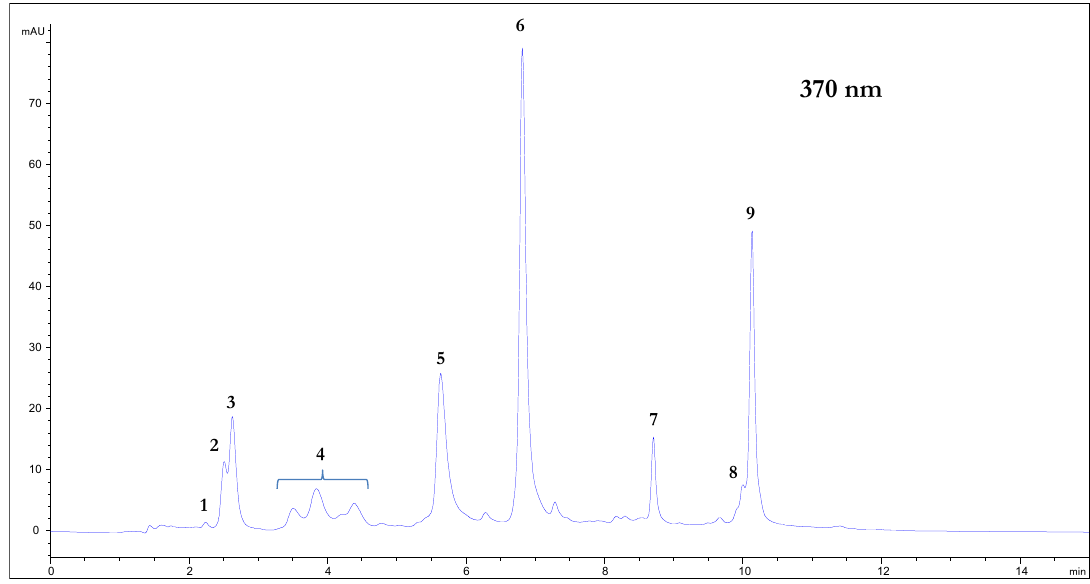
Figure 1. Chromatographic profiles at 370 nm of dried decoction with the main identified peaks: 1, gallic acid (identified in the chromatogram at 280 nm); 2, α -punicalin; 3, β -punicalin; 4, punicalagin derivatives; 5, α -punicalagin; 6, β -punicalagin; 7, ellagic acid hexoside; 8, ellagic acid pentoside; 9, ellagic acid.